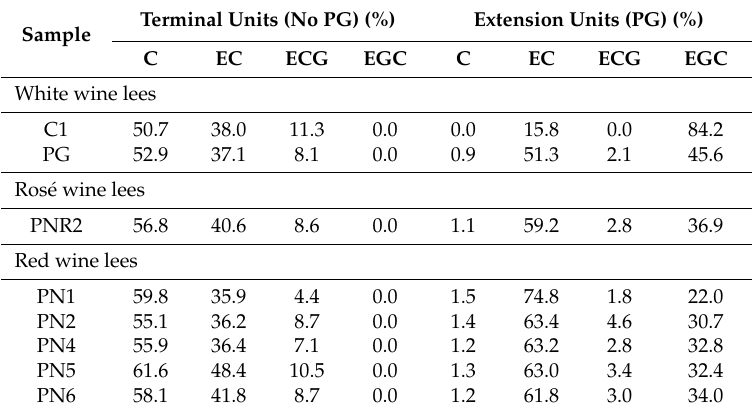
Table 2. Percentage of monomers in the breakdown of the phenolic in polymer fractions.